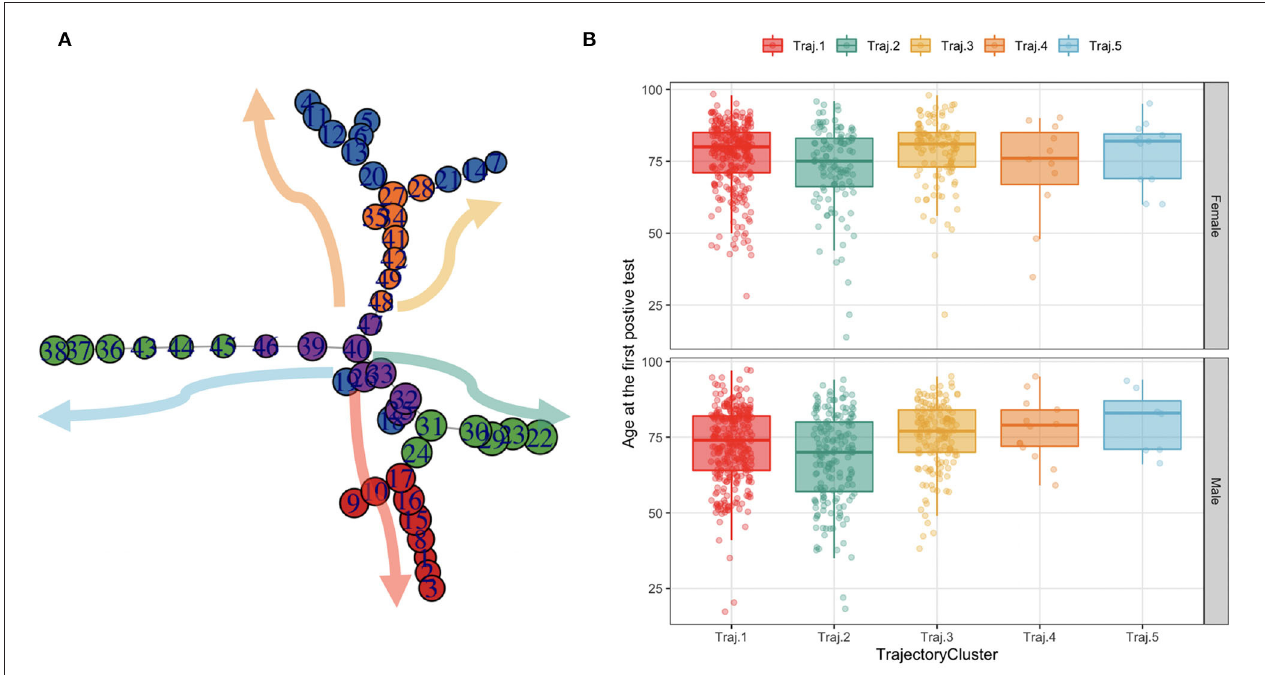
FIGURE 7 | The trajectories mined from the topology and their age distribution in females and males. (A) Each node in the graph on the leftmost side represents a cluster of data points as observations in time (i.e., a measure of a lab value). The node coloring is based upon topological structure membership. (B) The boxplots on the rightmost side represent the age at the first SARS-CoV-2 PCR test distribution by trajectory in females and males.